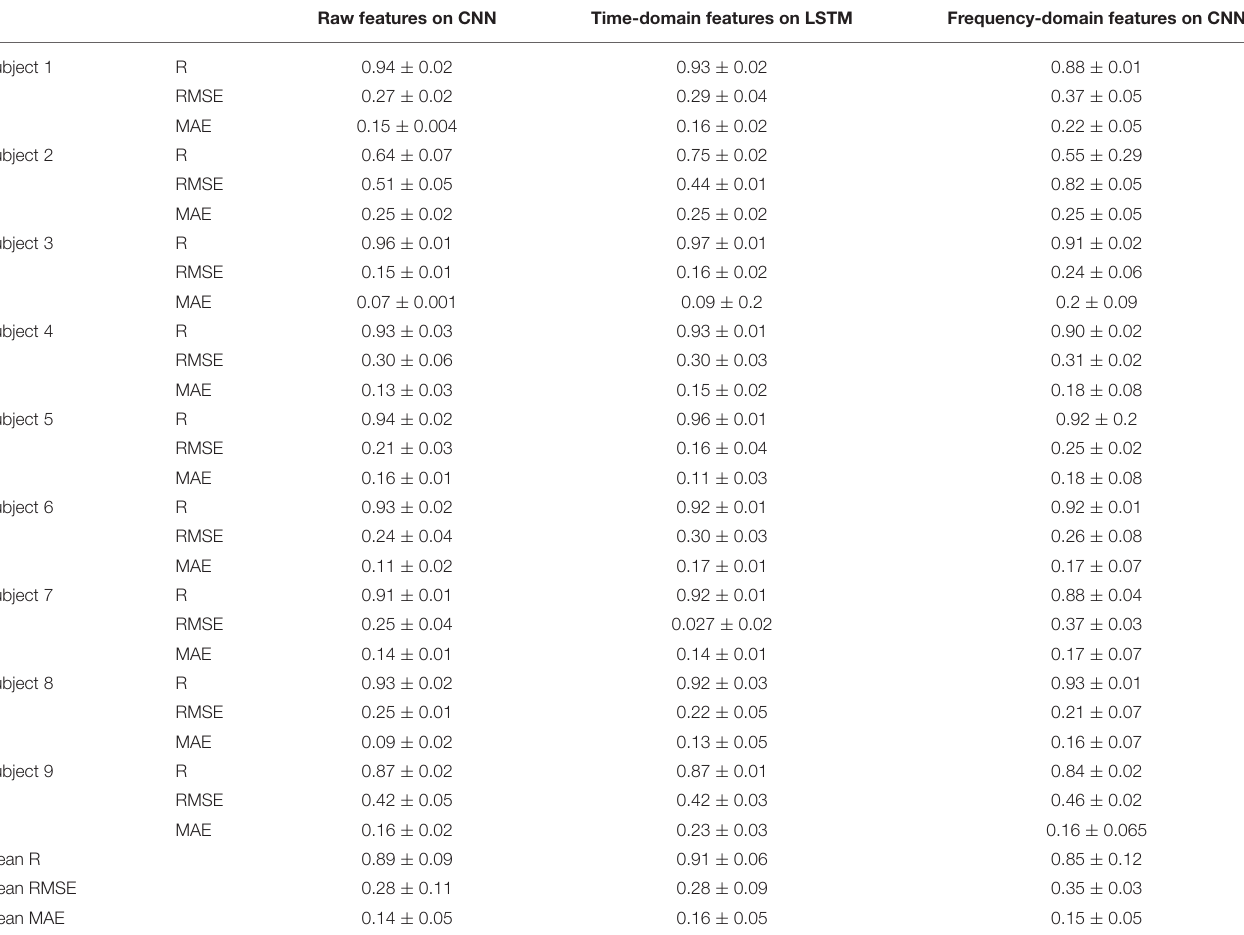
TABLE 3 | The subject-wise and averaged metric values of the 9 subjects for the Long-Short Term Memory (LSTM) and Convolutional Neural Network (CNN) on the three feature